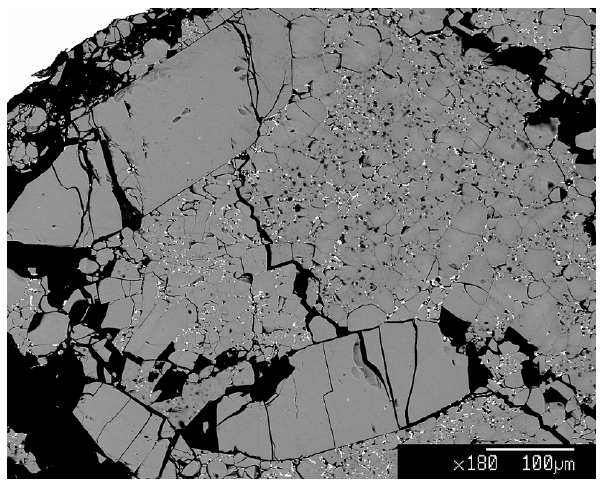
Figure 1. Burbankite synthetic batch. Dark grey minerals are bur- bankite crystals, while white spots are a Ca-rich La